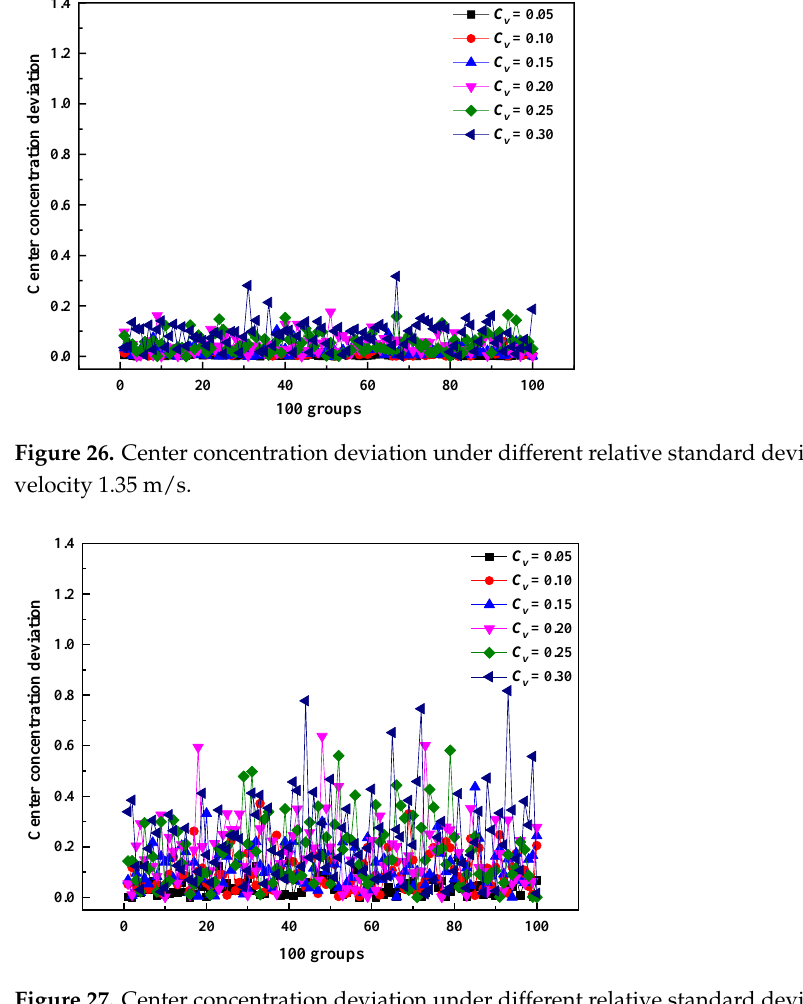
Figure 27. Center concentration deviation under different relative standard deviations of velocity at velocity 2.1 m/s.